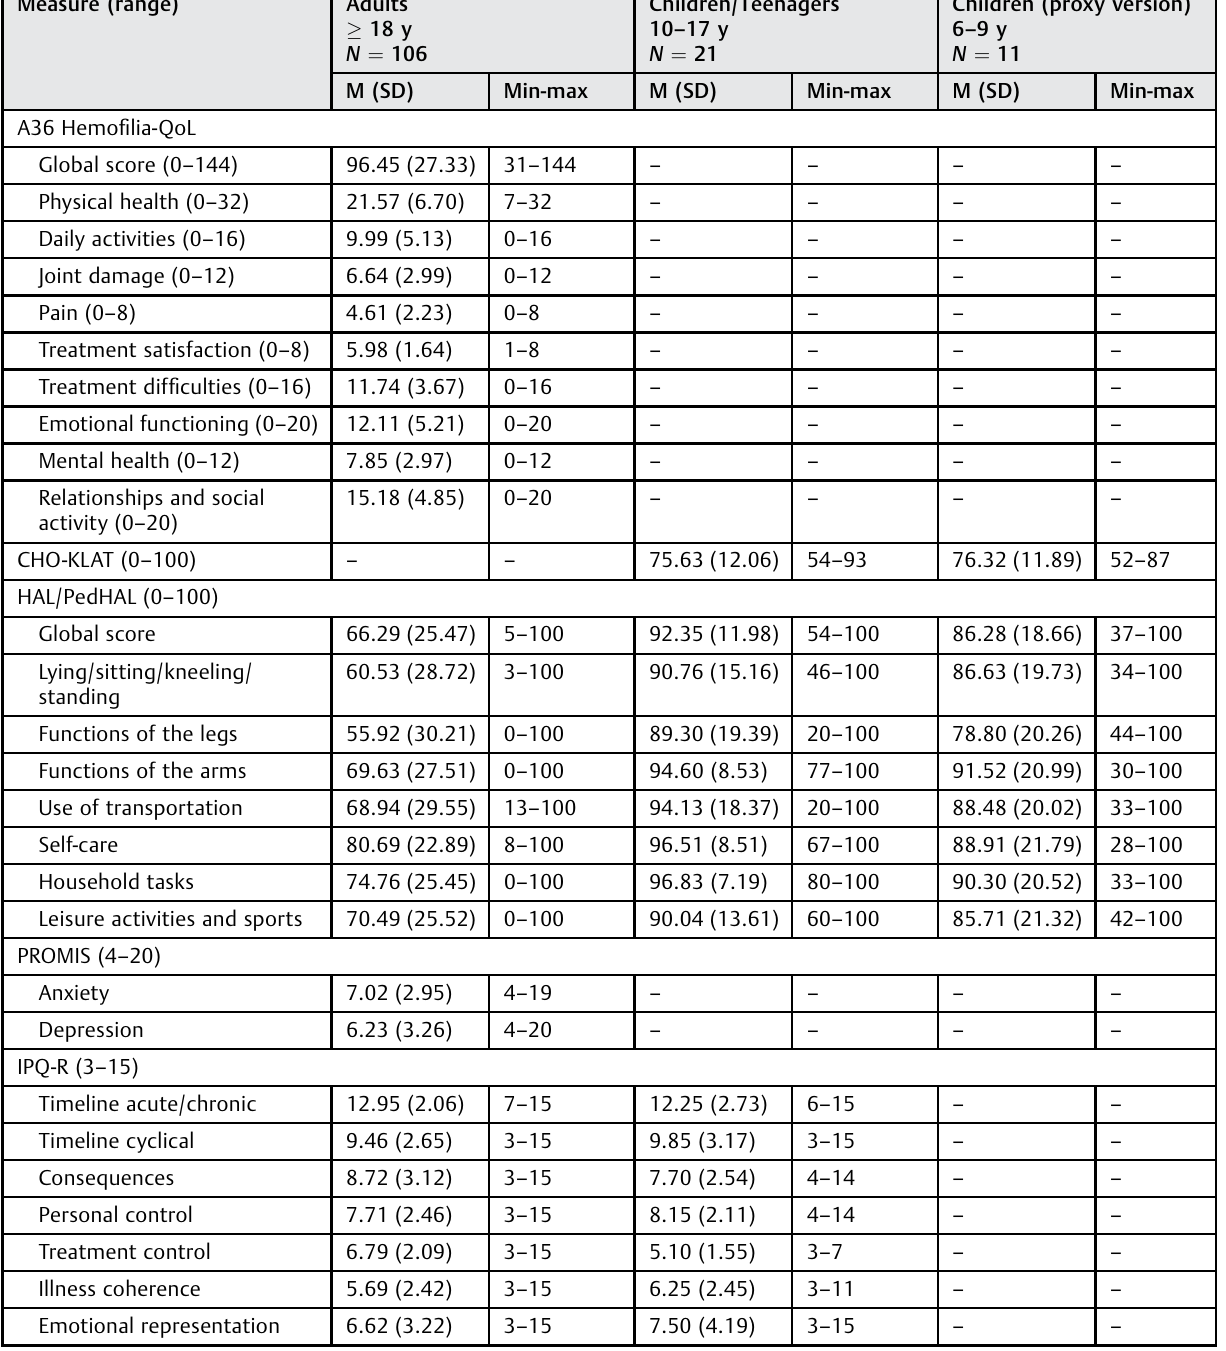
Table 5 Psychosocial and functionality variables among survey